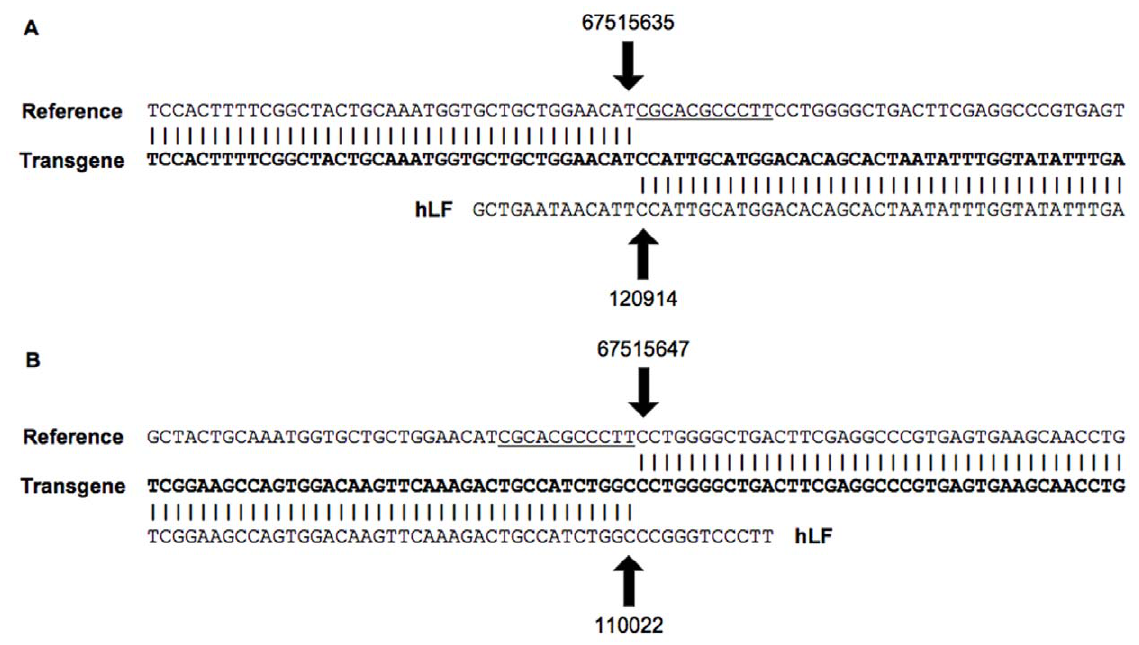
Figure 2. The transgene integration sites. The integration sites for the hLF BAC transgene on chromosome 15 in the bovine genome. (A) The left boundary of the integration site. (B) The right boundary of the integration site. Reference, the genomic DNA sequence of wide-type bovine; Transgene, the genomic DNA sequence of transgenic cattle; hLF, the DNA sequence of hLF BAC. The underlined regions indicate the deletion of 11 nucleotides in the genome.